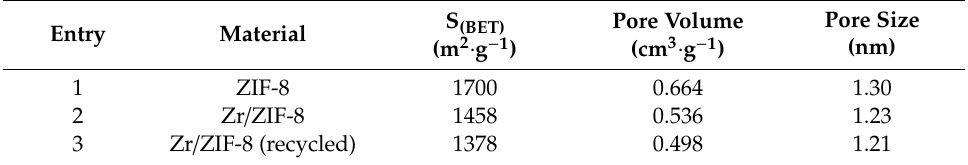
Table 1. Comparison of Brunauer-Emmett-Teller (BET) surface area analysis, pore-volume, and pore size for ZIF-8 and Zr / ZIF-8